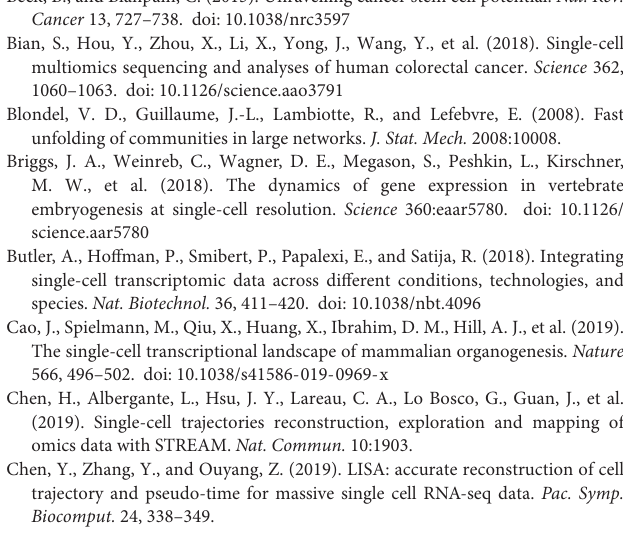
Supplementary Figure 3 | The PTA scores of marker gene expressions of each branch in cerebellum (A–H) from rank 1 to 3. In each heatmap, three columns are corresponding to the rank 1 to 3. Purkinje cell (PC), GABAergic Interneurons (GABA.IN), Bergermann glia (BG), medial cerebellar nuclei (mCN), Isthmic nuclear neurons (IsN), lateral cerebellar nuclei (lCN), granule cells (GC), GABAergic progenitor (GABA.pro). Supplementary Figure 4 | The marker gene expression of each branch in diencephalon (A–F) . The cells are ordered by pseudo time. In each heatmap, each column is corresponding to a cluster in the branch. The legend in the heatmap is corresponding to the clustering results in Figure 2B . Prethalamic neuros (pTh.N), rostral thalamic neurons (rTh.N), zona limitans intrathalamica (ZLI), epithalamic neuros (ETh.N), rostral pretecal neurons (rPT.N), caudal thalamus neuro I (cTh.N1), caudal thalamus neuro II (cTh.N2). Supplementary Figure 5 | The main gene expression trends (rank 1: red, rank 2: blue, rank 3: green) in each branch (A–F) in diencephalon are shown from rank 1 to rank 3 by PTA analysis. Here we only show the heatmap of normalized gene expression in rank 1 (A–F) . For all branches, we did down sampling using 50 as a group to compute the average signals as input of PTA. The gene expression data is the scaled data from Seurat. In the heatmap, all genes in rank 1 are ranked by the scores (values in the bar plot) from negative to positive. Negative value means that the gene expression is reverse to the trend. Positive value means that the gene expression is consistent with the trend. We set a threshold 0.03 to filter the genes with low absolute scores and show the genes with top 30 positive and smallest 30 negative scores. Prethalamic neuros (pTh.N), rostral thalamic neurons (rTh.N), zona limitans intrathalamica (ZLI), epithalamic neuros (ETh.N), rostral Supplementary Figure 6 | The PTA scores of marker gene expressions of each branch in diencephalon (A–H) from rank 1 to 3. In each heatmap, three columns